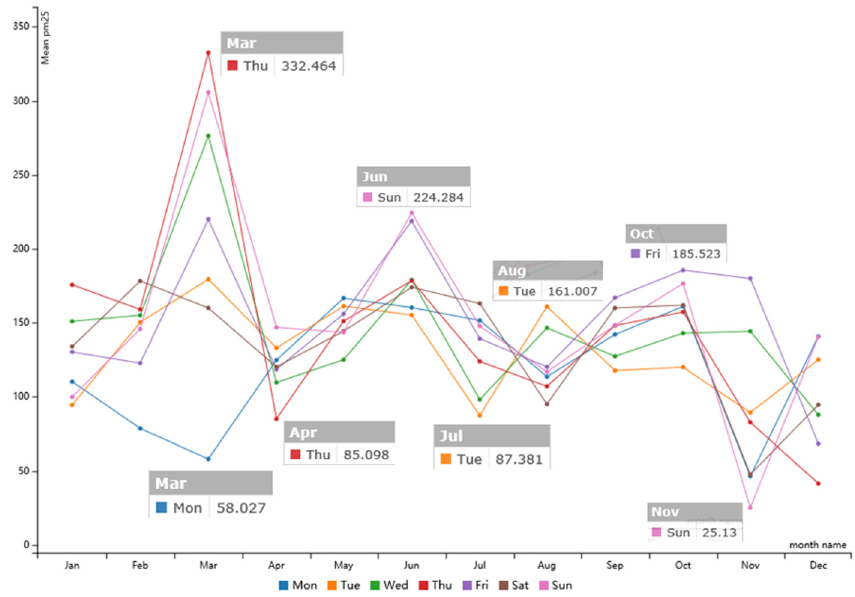
7 of 19 Figure 4. Heat table of month and week mean air quality index of PM 2.5 . Table 1. Visualized design for discovery of defects in the U-Air data. Stations (ID) Months Mean AQI of PM 2.5 Part (01–22) All months Relationship with Month, Day, Hour All (01–36) Part (1, 2, 11, 12)